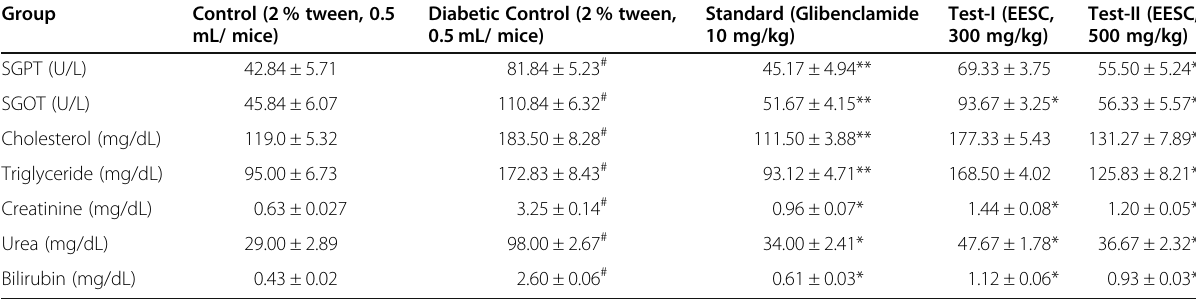
Table 10 Effect of S. caseolaris fruits on SGPT, SGOT, total Cholesterol, triglyceride, creatinine, urea and bilirubin in STZ-induced diabetic mice